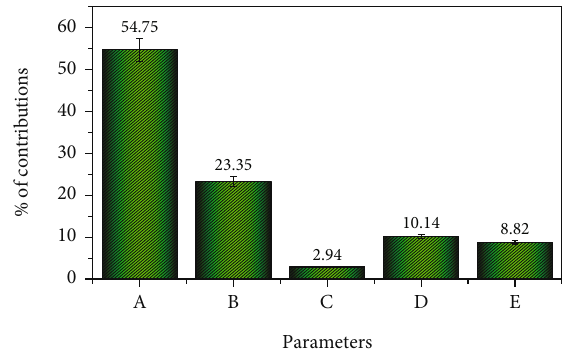
Figure 2: Error plots of percent contributions of various in fl uencing parameters of iodine adsorptions.